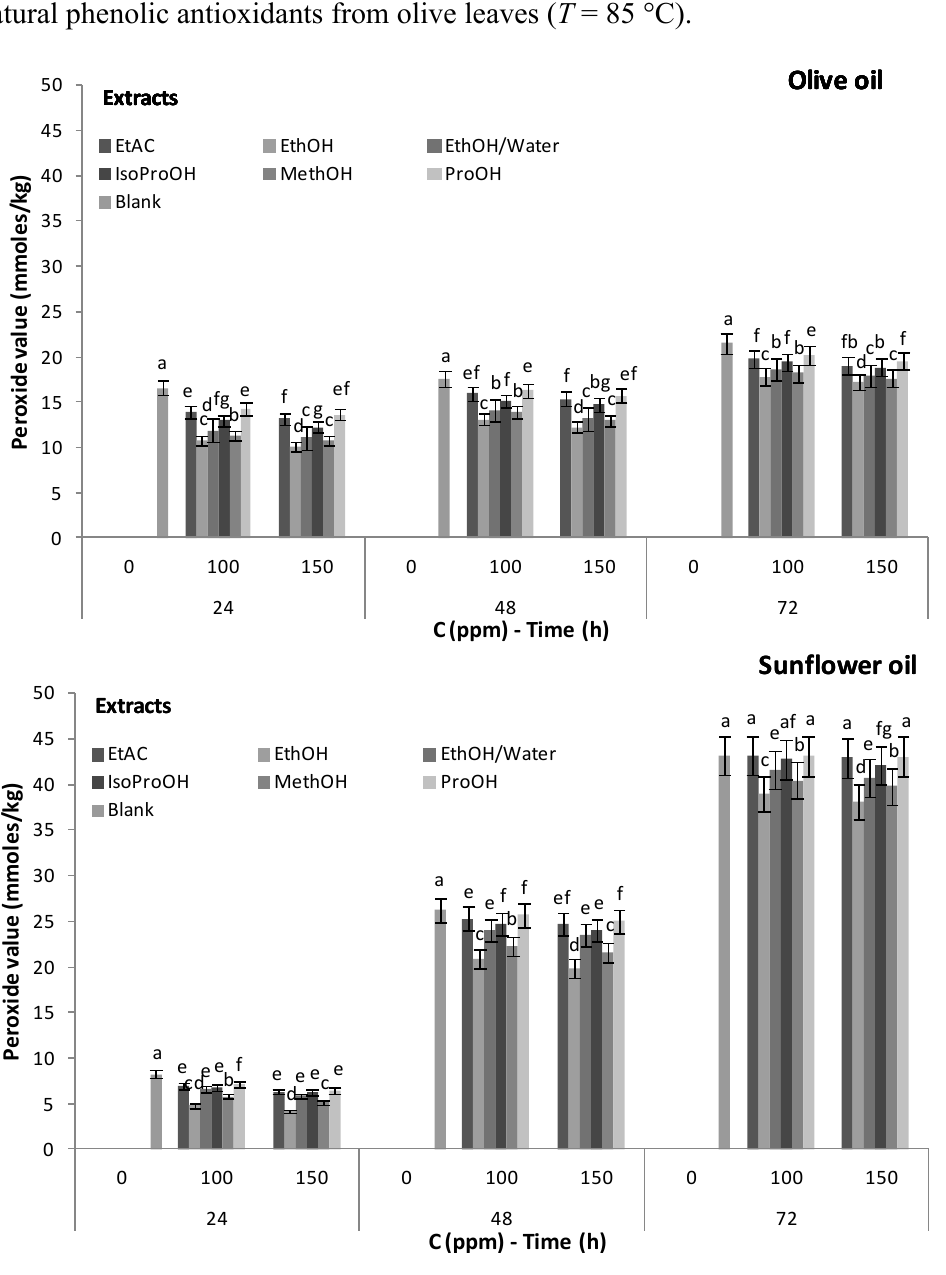
Figure 3. Peroxide value (mM/kg) of olive oil and sunflower oil enriched or not enriched with natural phenolic antioxidants from olive leaves ( T = 85